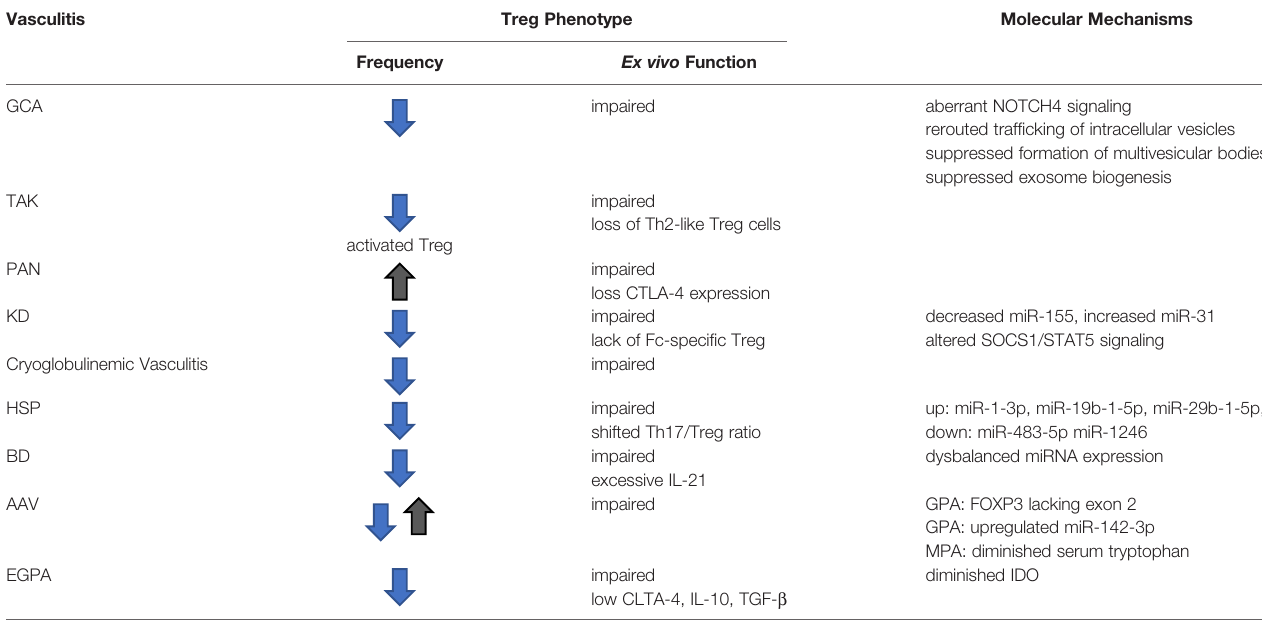
TABLE 1 | Treg Dysfunction in Autoimmune Vasculitis.